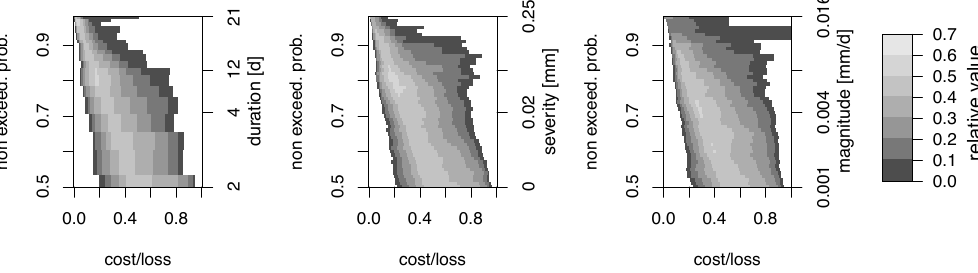
Fig. 10. Relative economic value of Thur ensemble forecasts of streamflow drought duration, magnitude and severity (columns) using the varying 15th quantile of runoff as the streamflow drought detection threshold. The economic value is shaded in gray for forecast users with different cost-loss ratios (x-axis) and for different event thresholds. The left y-axis shows the non-exceedance probability and the right y-axis the quantiles for the 50th, 70th, 80th and 95th non-exceedance